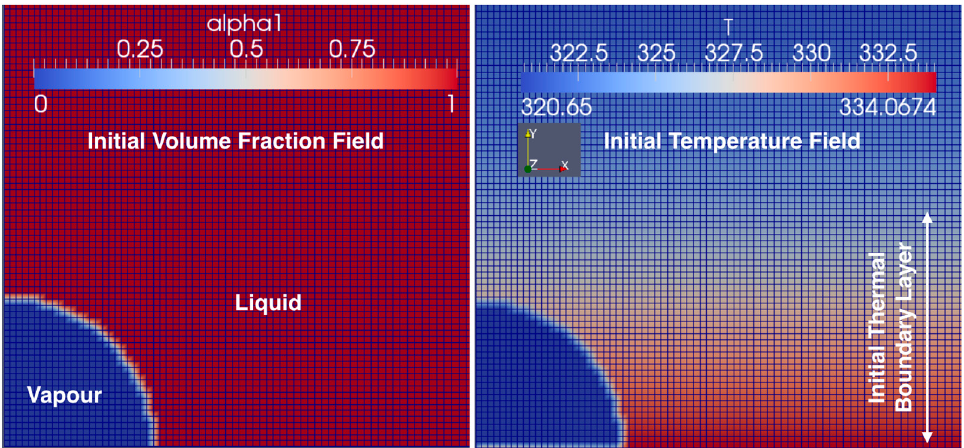
Figure 8. Initial conditions for the simulation.